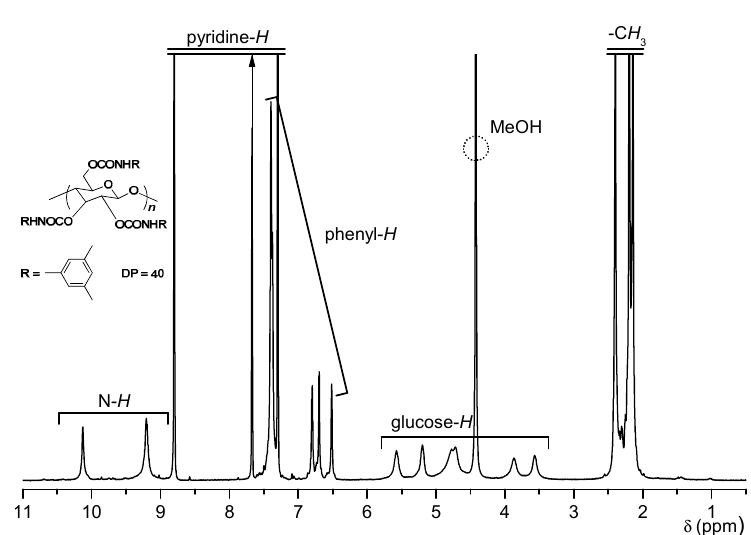
Figure 1. 1 H-NMR spectrum of cellulose tris(3,5-dimethylphenylcarbamate) with DP 40 in pyridine- d 5 at 80 °C (500 MHz).